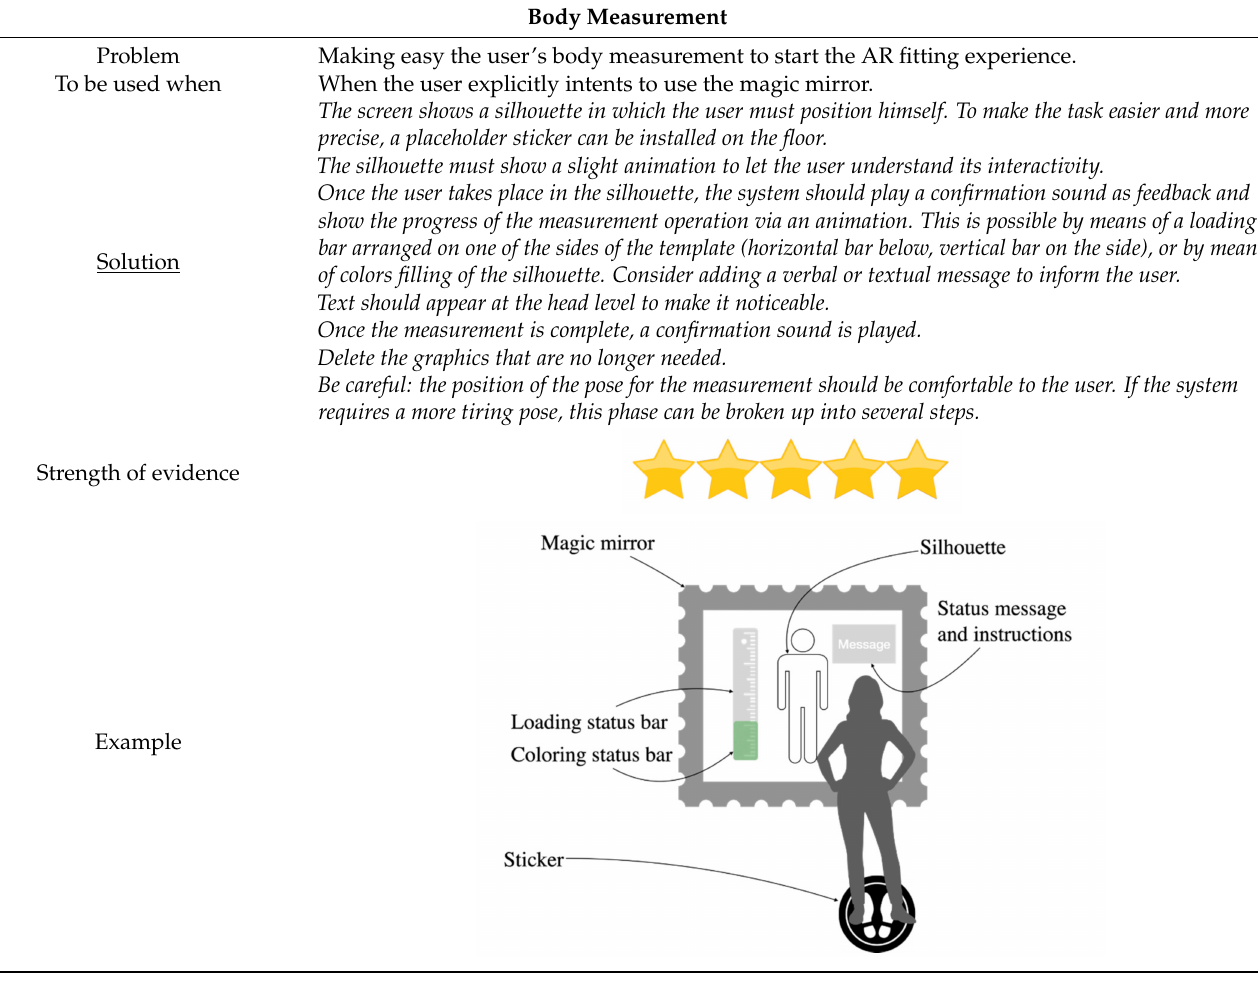
Table 4. Intuitive and comfortable interaction